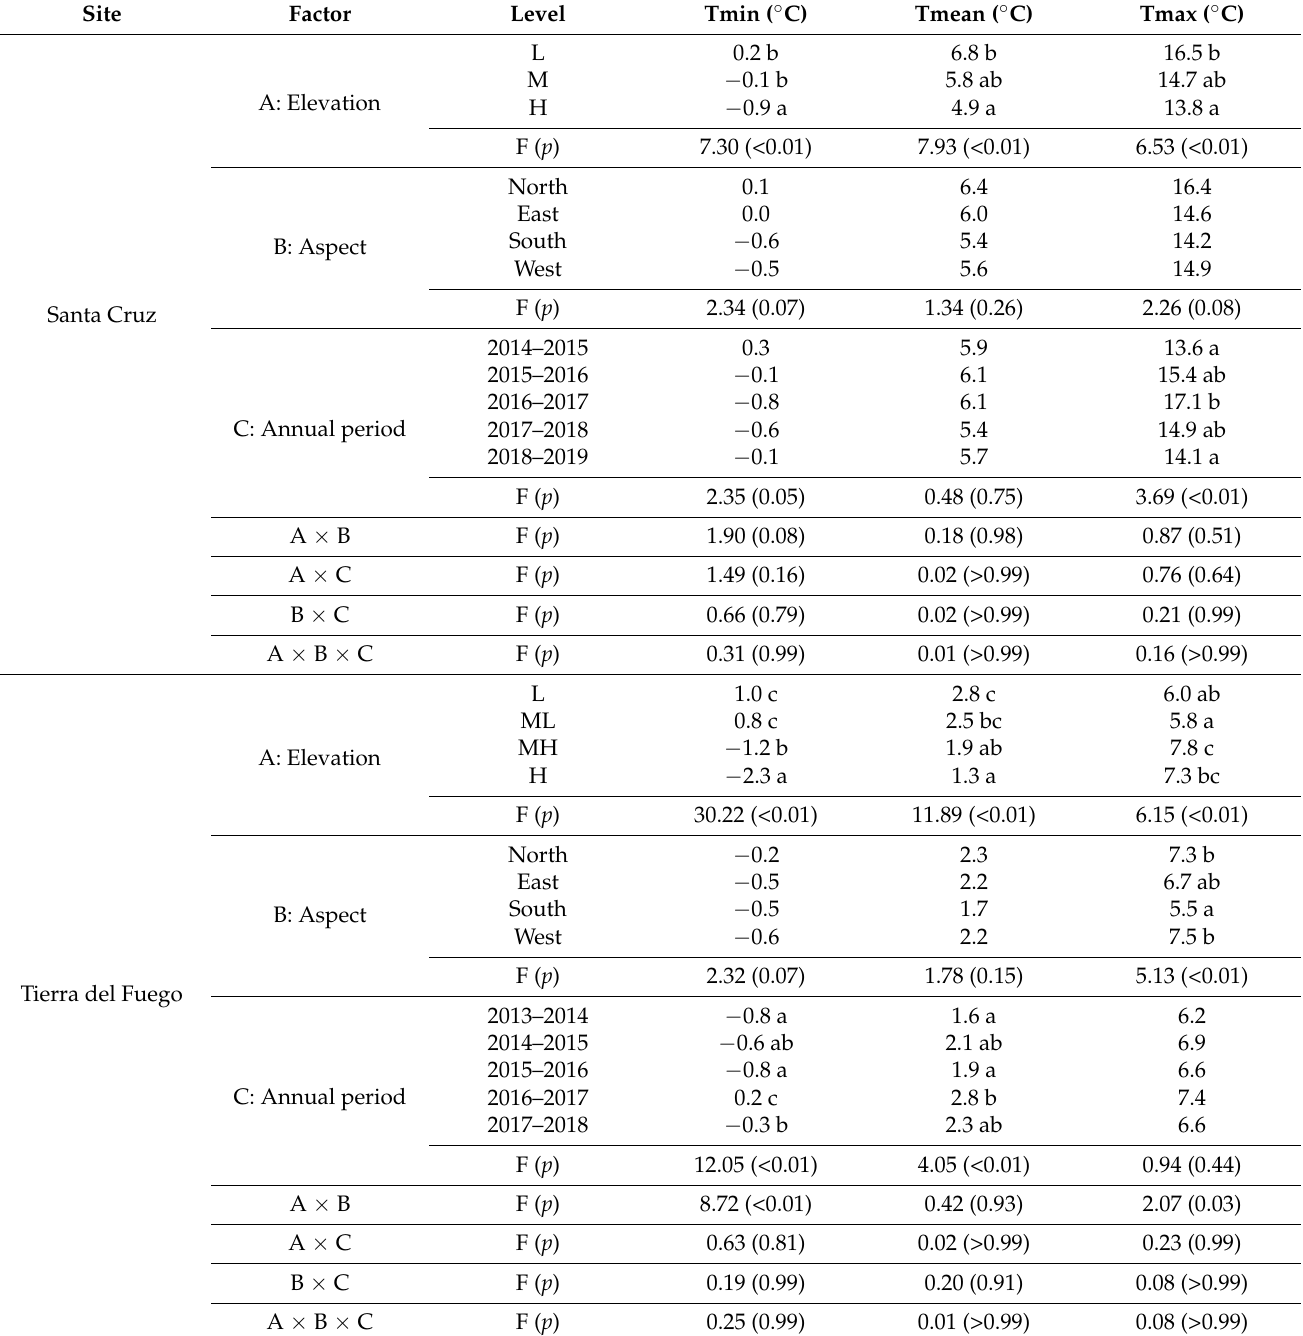
F ( p ) = Fisher test with significance level in parentheses. Different letters in a column indicate significant differences ( p < 0.05) by the Tukey